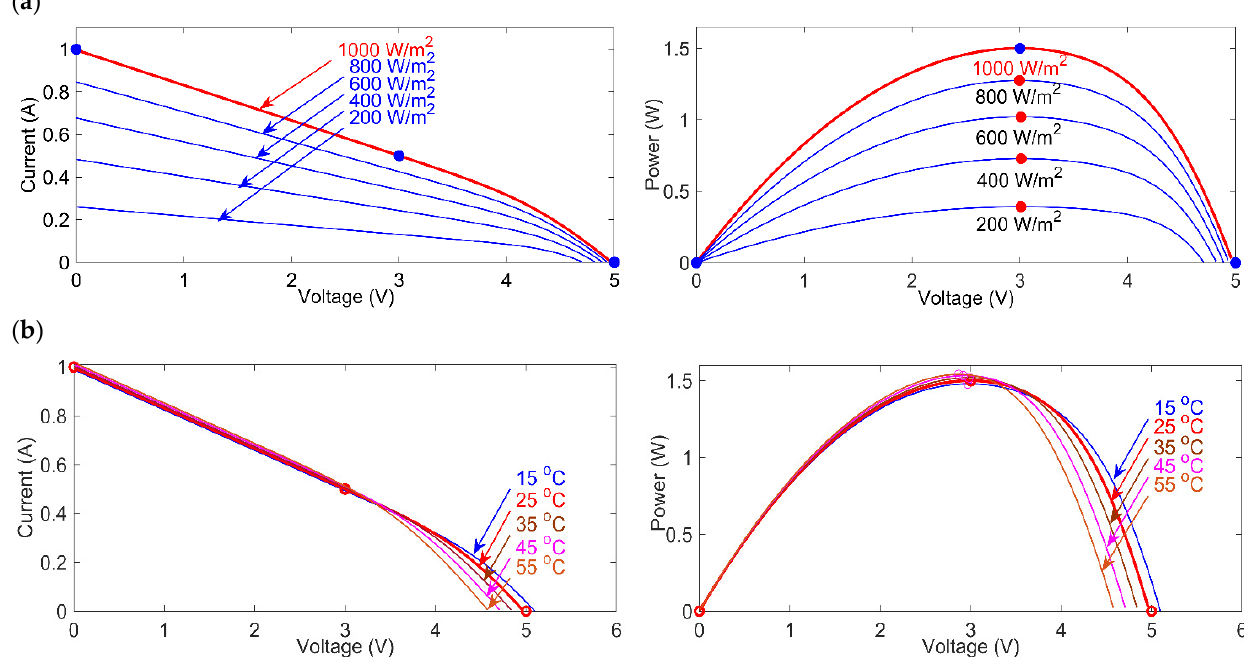
Figure 5. Solar module AM-1816 characteristics ( a ) I-V and P-V characteristics at different irradiance (W/m 2 ), ( b ) I-V and P-V characteristics at different temperature (°C).